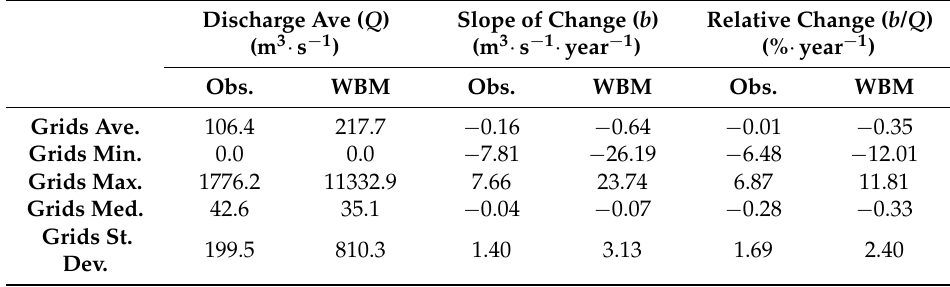
Figure 2 . WBM model versus observations streamflow data 1971–2001 boxplots for Coterminous US— Log of annual-averaged daily streamflow map for observations ( a ), Slope of change in streamflow map for observations ( b ) and relative change in annual-averaged daily streamflow map for observations ( c ). Values larger than 99 th and smaller than 1 st percentile of the data (considered as the